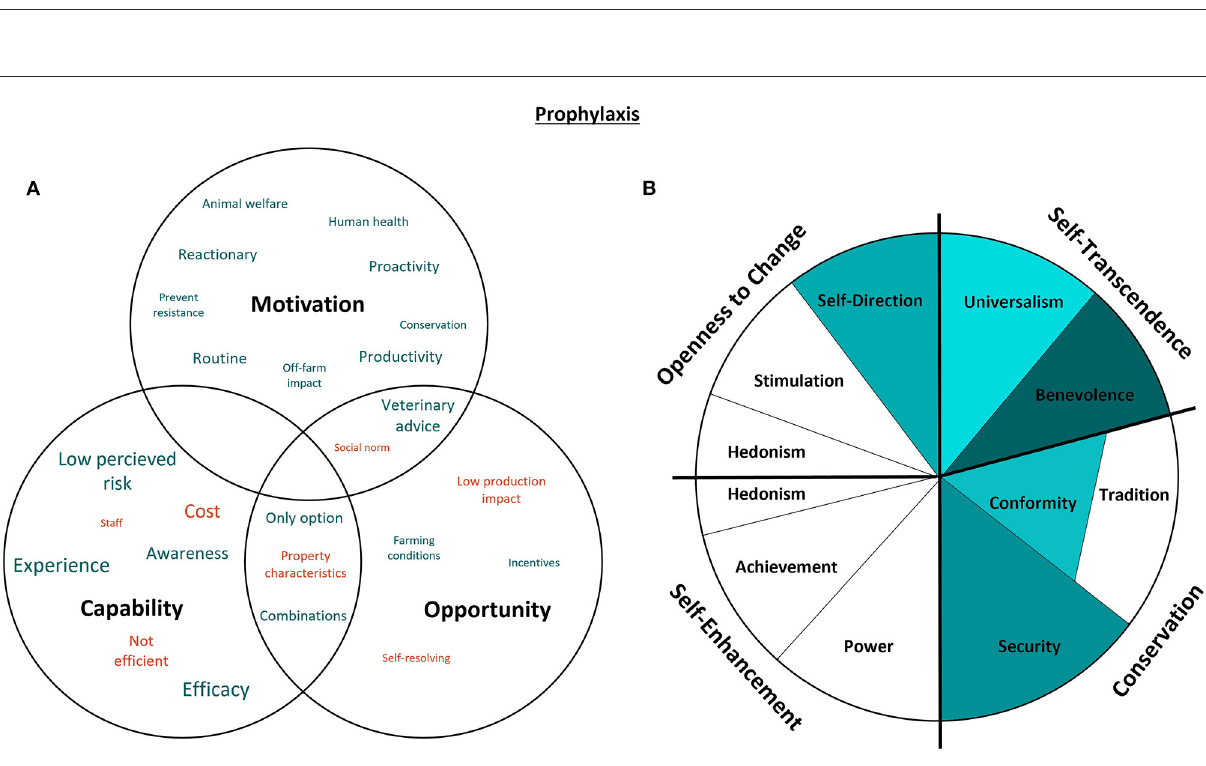
FIGURE8 Capability, opportunity, motivations and values associated with the use of prophylaxis in beef cattle. Green represents attributes that promote the use of prophylaxis, while red indicates confounding attributes. The size of the text in the Venn diagram (A) indicates commonality of themes amongst the participants, as does darker shading in the value wheel (B) [adapted from Schwartz (29). CC BY-SA